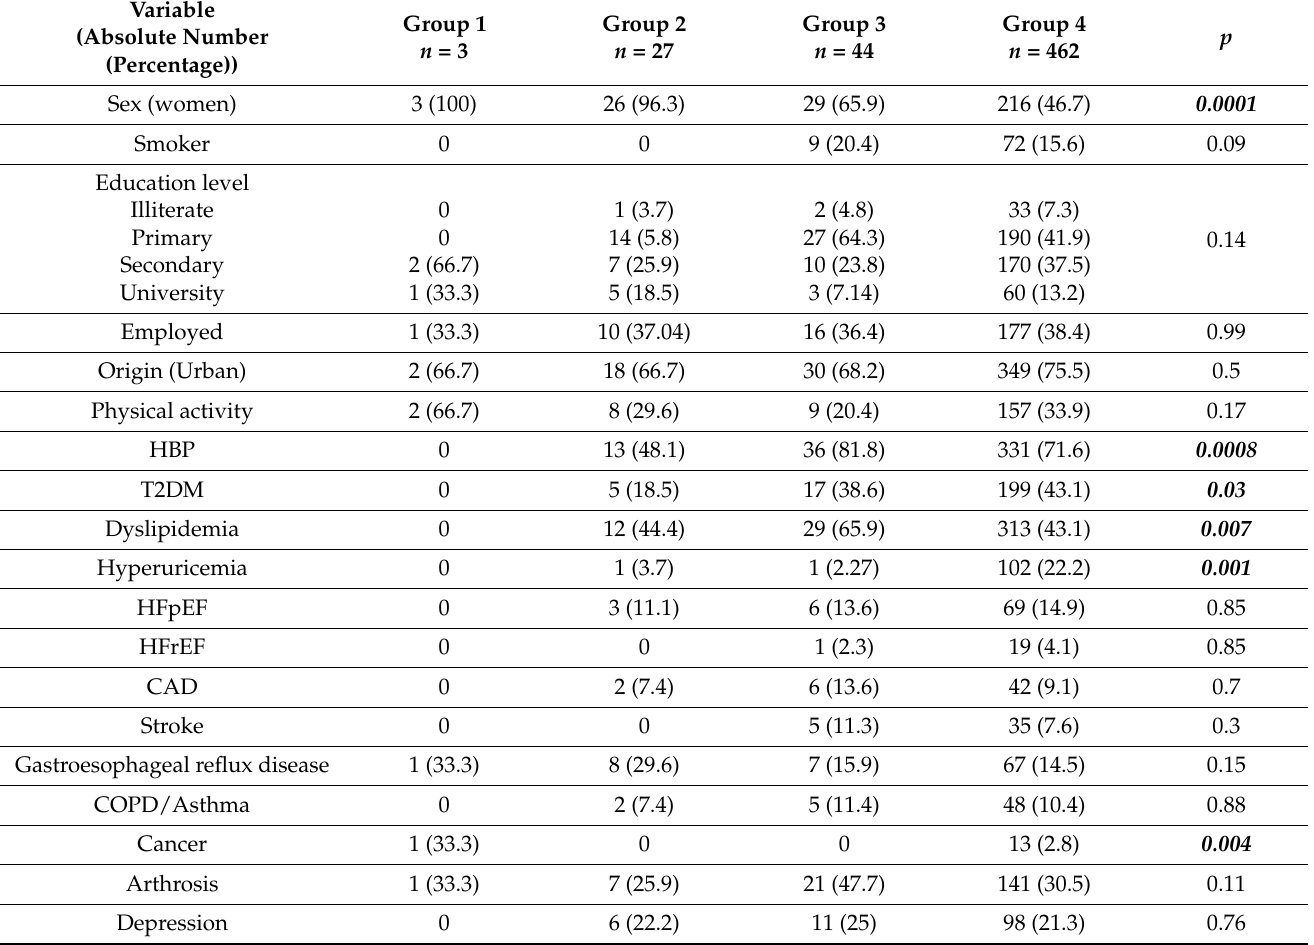
Table 1. Qualitative Variables by